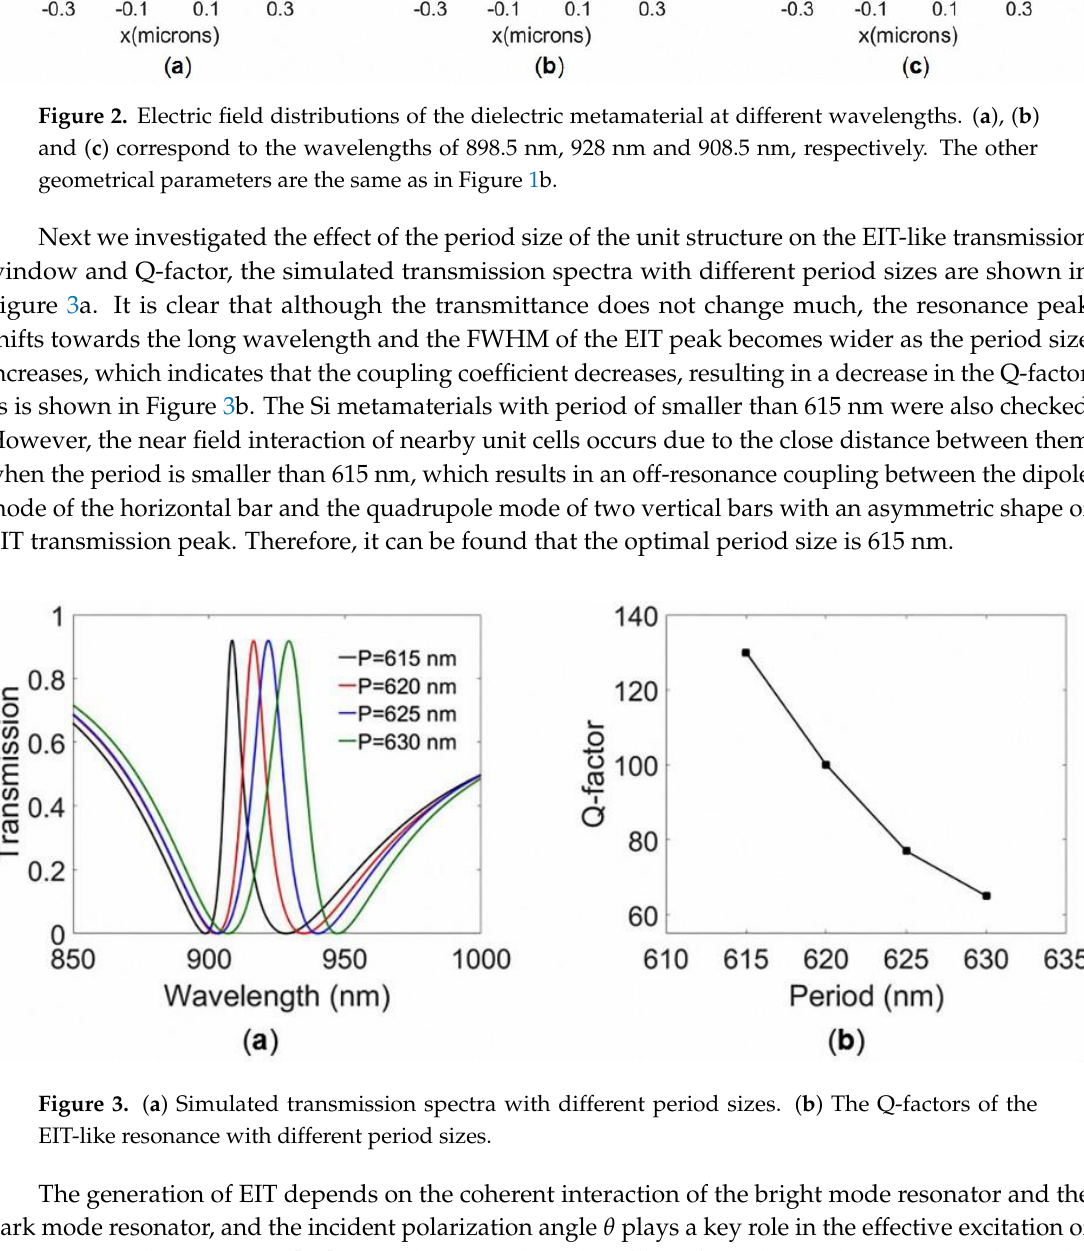
Figure 2. Electric field distributions of the dielectric metamaterial at different wavelengths. ( a ), ( b ) and ( c ) correspond to the wavelengths of 898.5 nm, 928 nm and 908.5 nm, respectively. The other geometrical parameters are the same as in Figure 1b.